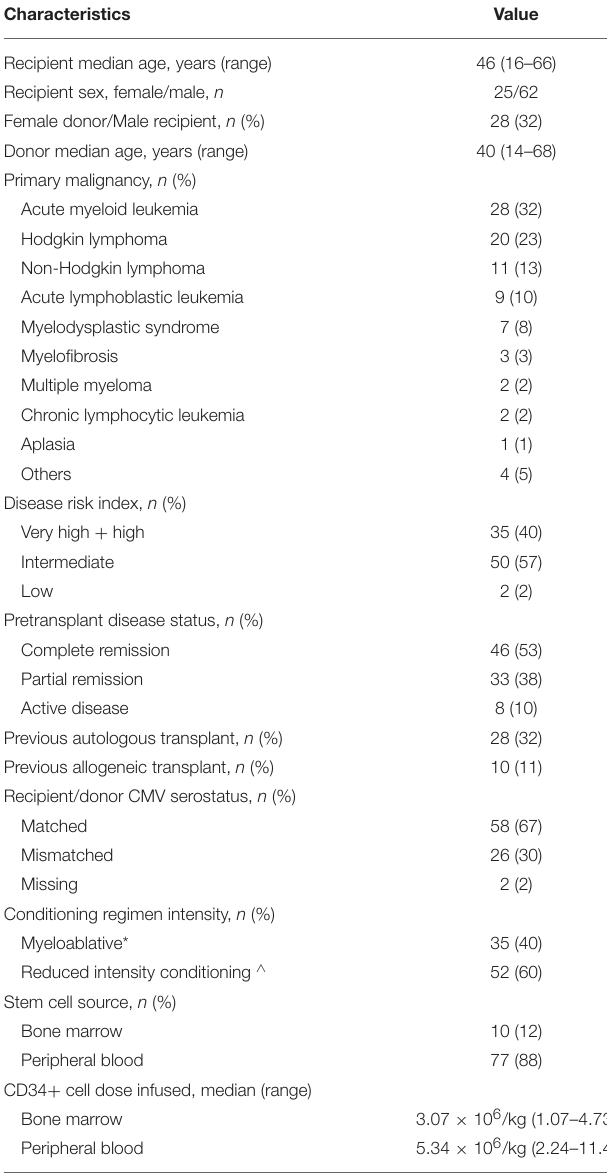
TABLE 1 | Clinical features of patients and transplants.